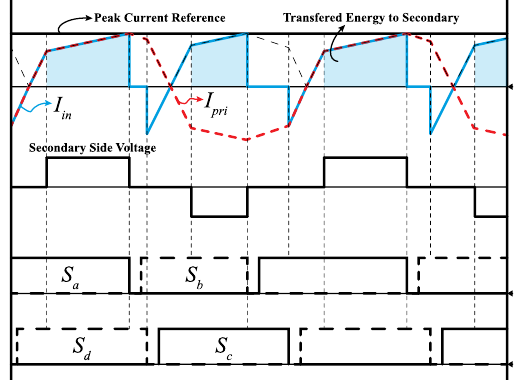
Figure 5. Sub-harmonic oscillation in the primary-side current of PCMC-based PSFB converters when the duty ratio exceeds